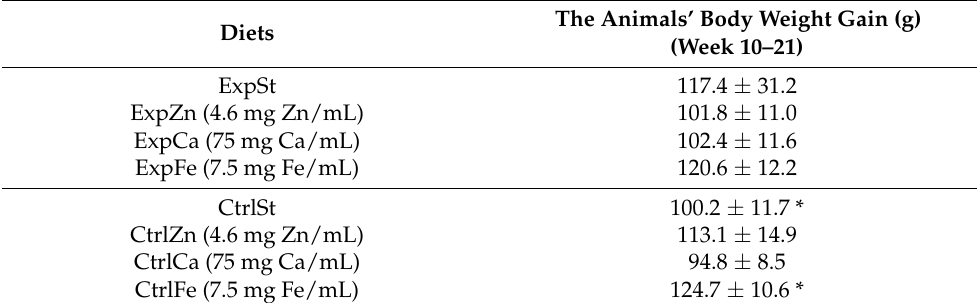
Table 4. The animals’ body weight gain [g] (week